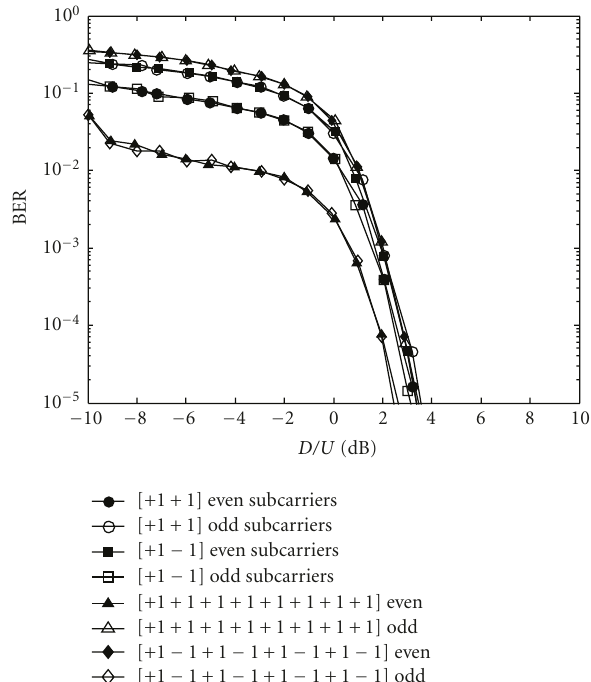
Figure 8: BER performance of OFDM for even and odd numbered subcarriers interfered with by